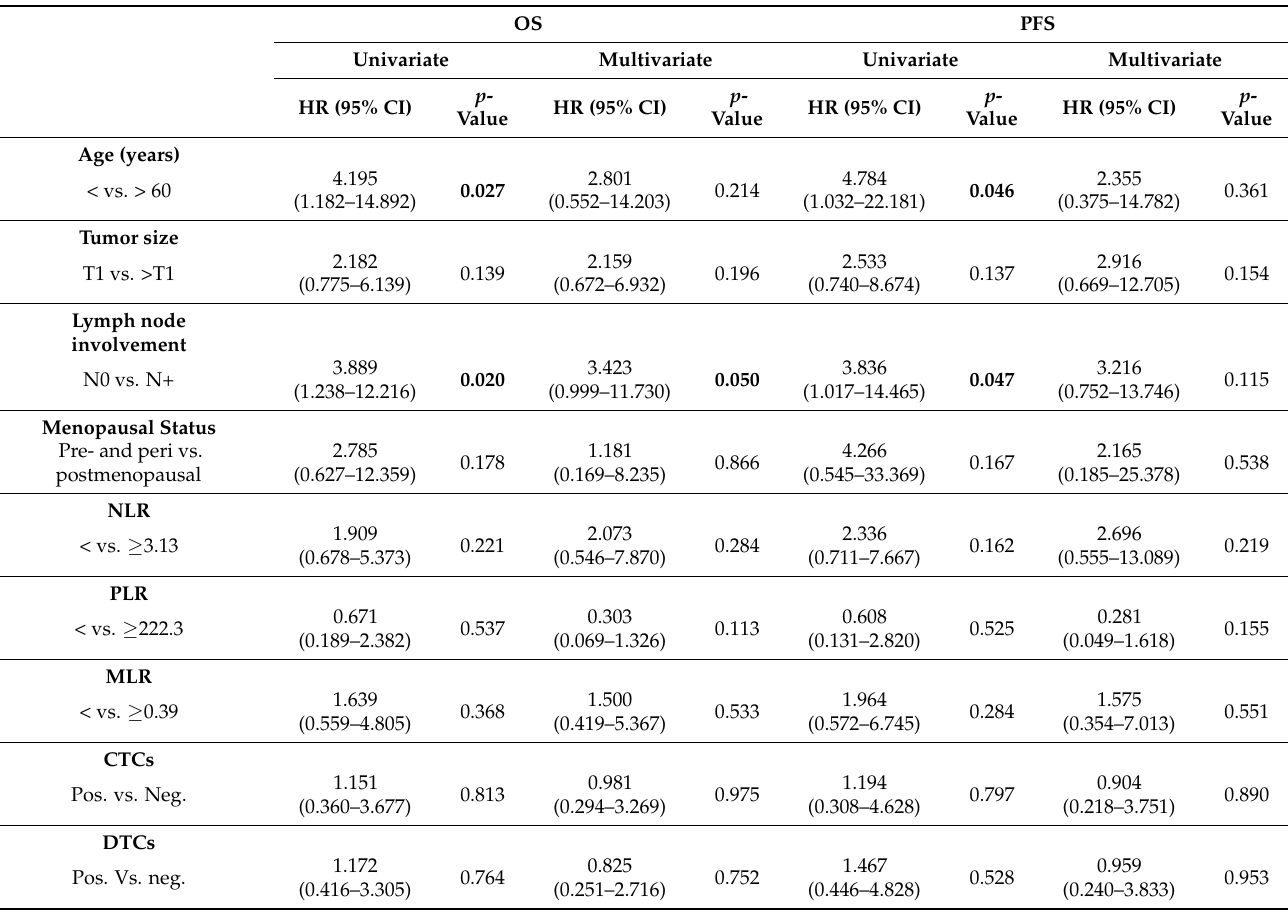
Table 5. Cox proportional hazards regression (HR) model for univariate and multivariate analyses for the ratios, clinical characteristics and outcome. CTCs: circulating tumor cells; DTCs: disseminated tumor cells; MLR: monocyte-to-lymphocyte ratio; NLR: neutrophil-to-lymphocyte ratio; OS: overall survival; PFS: progression-free survival; PLR: platelet-to-lymphocyte ratio. OS PFS Univariate Multivariate Univariate